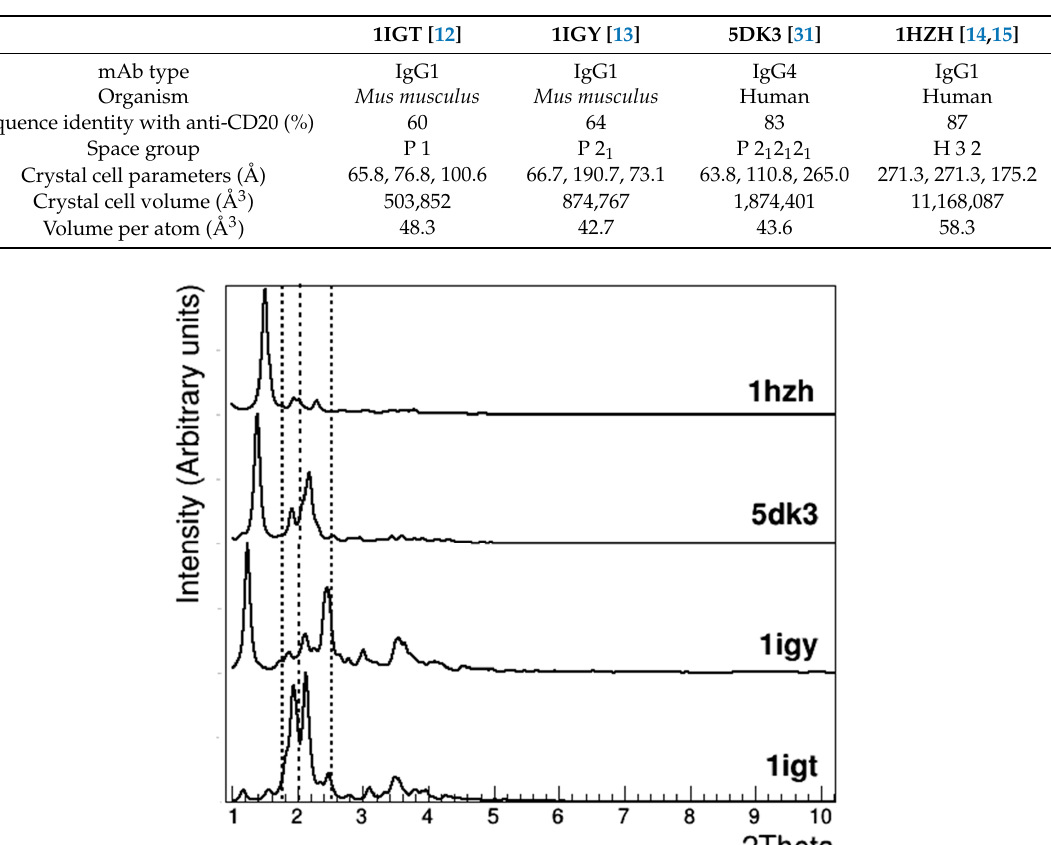
Table 1. Properties and crystallographic parameters of known crystal structures of intact monoclonal antibodies (mAbs). CD20—cluster of di ff erentiation